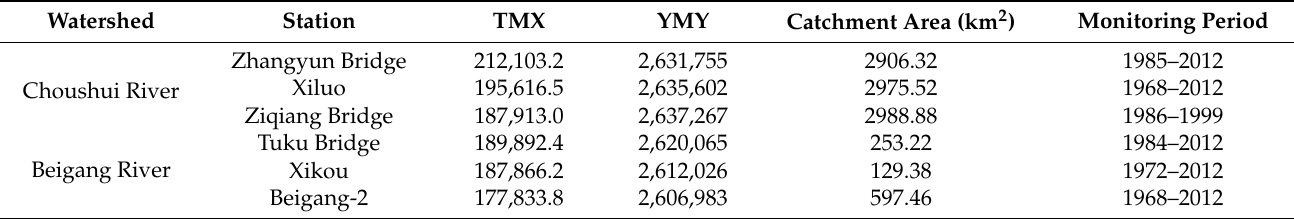
Table 3. Assessment results of baseflow index and recharge rate in the Choushui River alluvial fan.